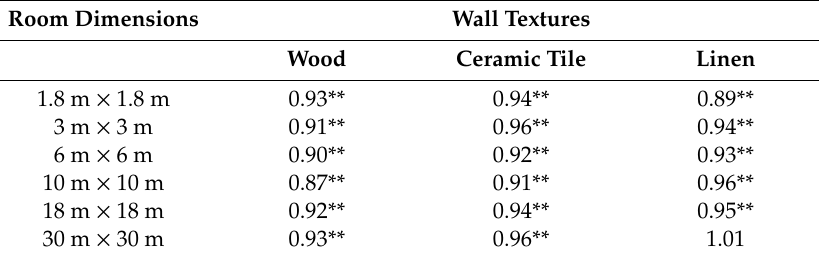
Table 4. Mann–Whitney U test Results for Experiment 2.